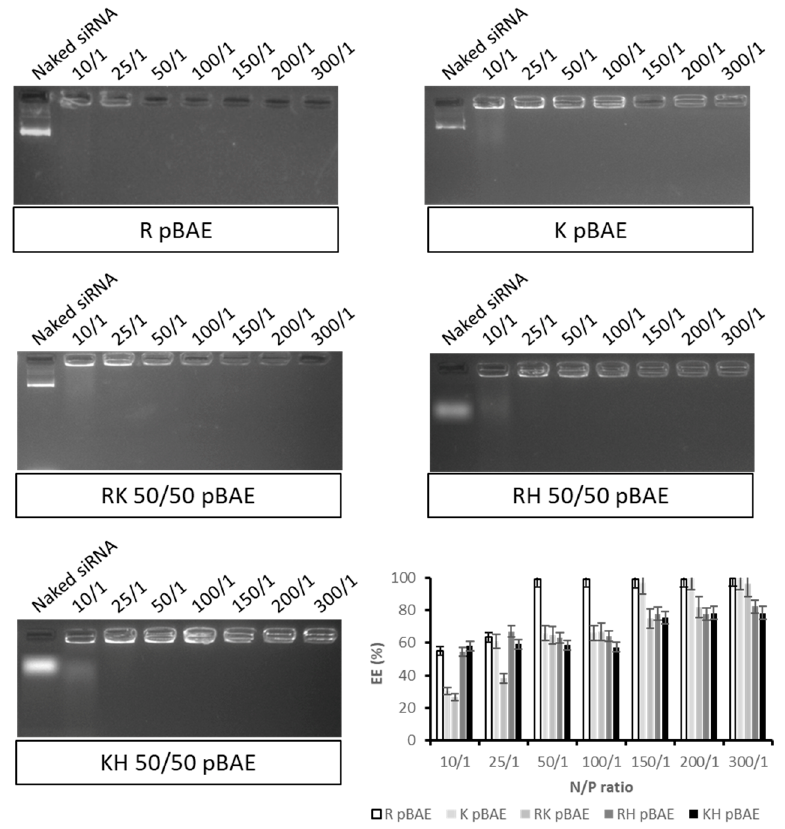
Figure 1. EMSA assay for the determination of siRNA encapsulation. Testing different N/P ratios and oligopeptide combinations, encapsulating a scrambled siRNA non-targeting pool.